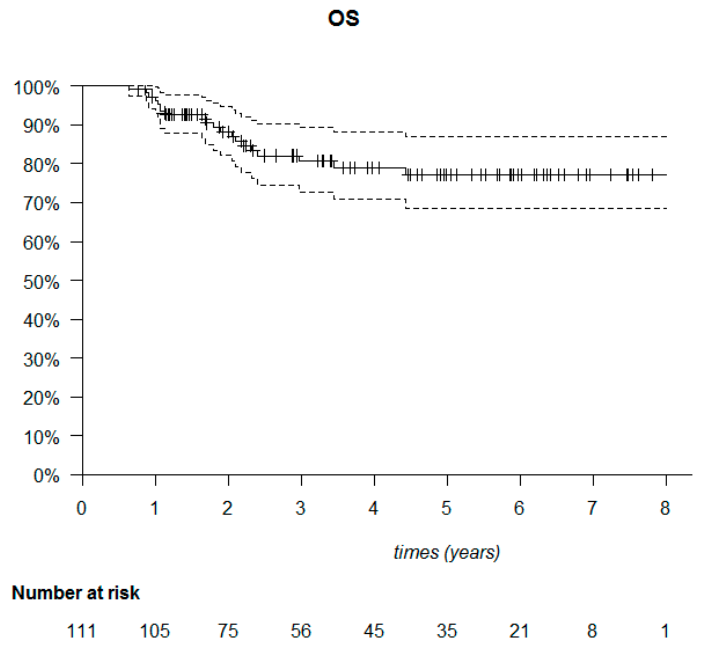
Figure 7. Kaplan–Meier overall survival (OS) of the 111 triple-negative breast cancer patients.